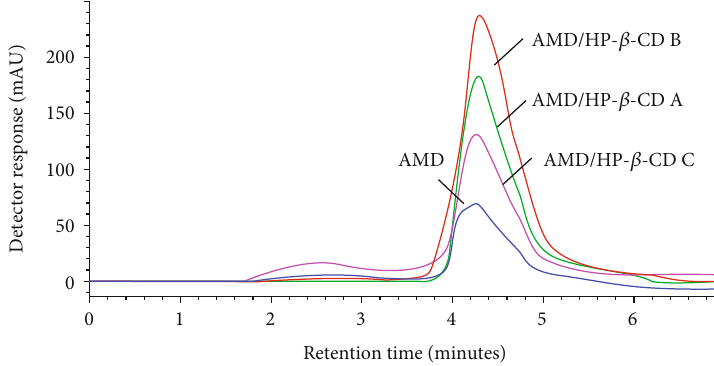
Figure 13: HPLC chromatograms of the three inclusion complexes: AMD/HP- β A, AMD/HP- β B, and AMD/HP- β C and AMD. Table 5: AMD loading e ffi ciency in inclusion complexes.